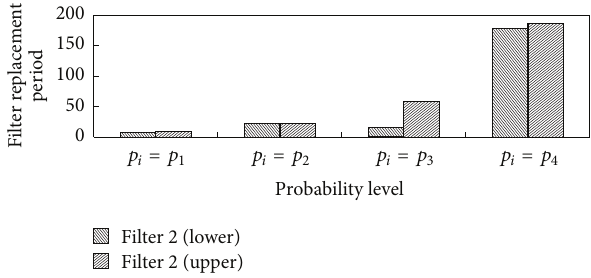
Figure 7: Filter replacement periods for Scenario 2 under high contaminant ingression/generation